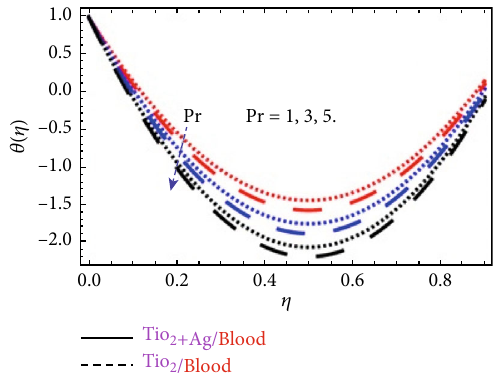
Figure 8: Inspiration of Reedition parameter R on temperature pro fi